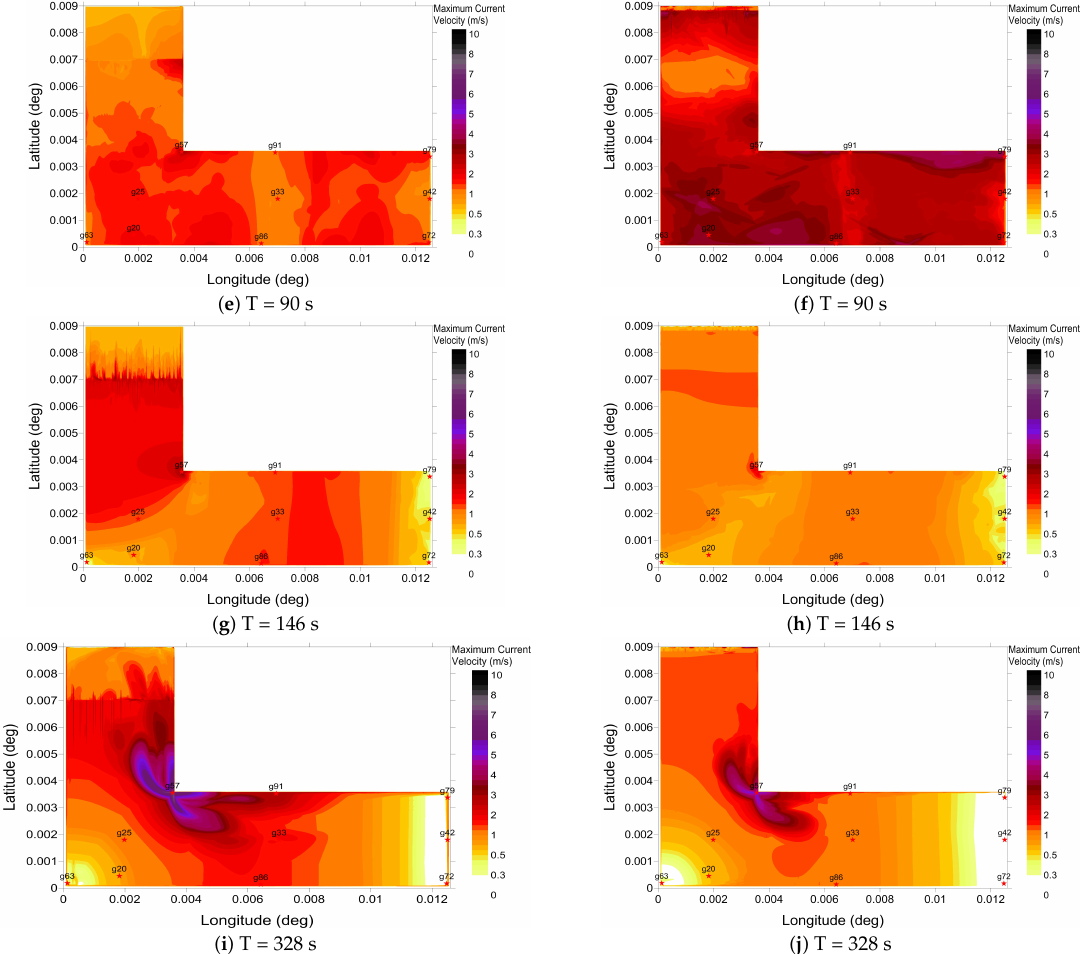
Figure 4. The spatial distribution of the maximum current velocity (m/s) computed by the simulation of the sinusoidal line crest long wave with a 1-m wave amplitude with T = 16 s, T = 46 s, T = 90 s, T = 146 s, T = 328 s for LA/LB = 0.8 in the left column and LA/LB = 1 in the right column ( a – j